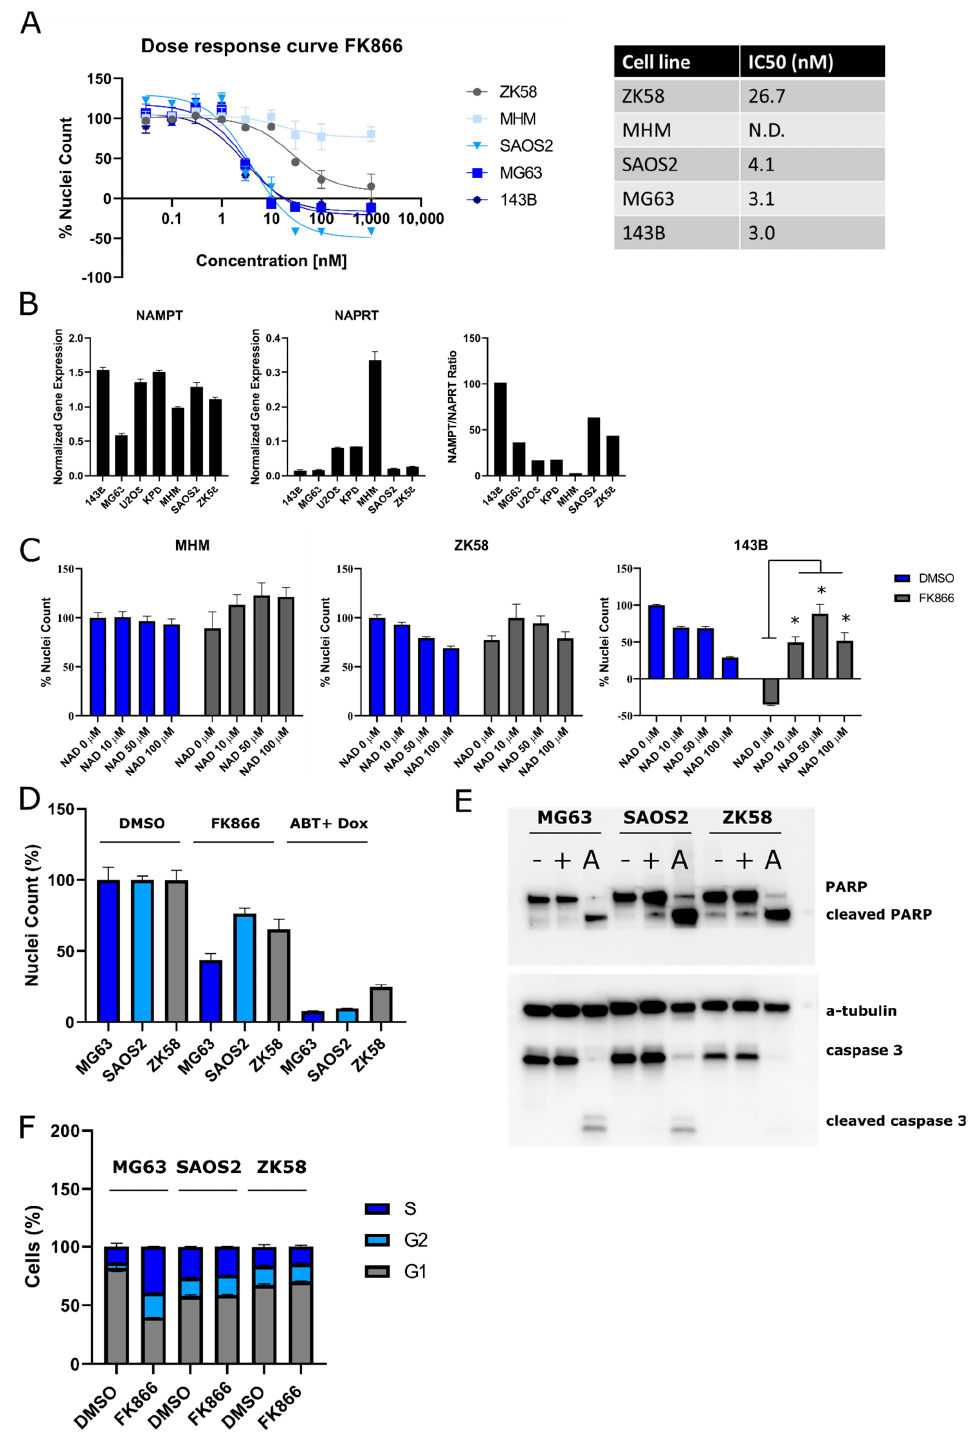
Figure 2. The NAMPT inhibitor FK866 decreases cell viability in 2D cultured osteosarcoma cell lines. ( A ) Osteosarcoma cell lines were treated for 72 h with the NAMPT inhibitor FK866, after which relative cell viability and IC 50 values were determined. IC 50 could not be determined for MHM (N.D.). Data points represent the mean of two experiments performed in triplicate ± standard deviation. ( B ) Gene expression of NAMPT and NAPRT1 in osteosarcoma cell lines. ( C ) NAD+ rescues the inhibitory effect of the NAMPT inhibitor FK866 (10 nM) on cell viability. Bars represent the mean of two experiments performed in triplicate ± standard deviation. * = p < 0.05 ( D ) OS cells treated for 48 h with FK866 (5 nM (SAOS2 and MG63) or 60 nM (ZK58)) reduced cell viability. Cells treated with ABT-737 (5 µ M) and doxorubicin (1 µ M) were used as a positive control for the induction of apoptosis [17]. Bars represent the mean of two experiments performed